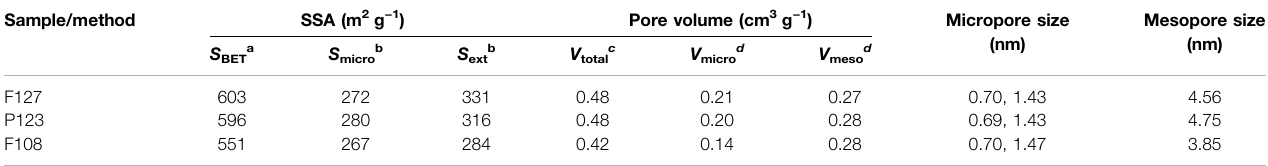
TABLE 1 | Structure properties of the obtained carbon samples from nitrogen adsorption-desorption characterization.